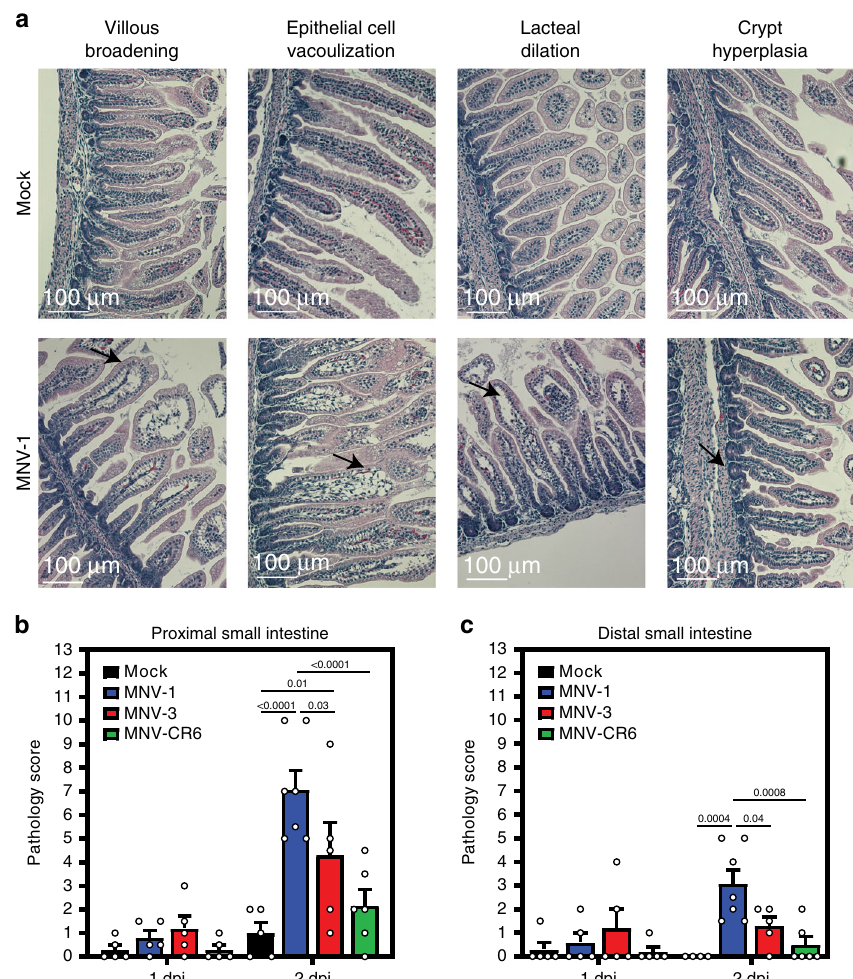
Fig. 3 Neonatal mice infected with MNV-1 show pathological changes. Small intestinal sections collected from neonates infected with 10 8 TCID 50 units of MNV-1 (blue), MNV-3 (red), MNV-CR6 (green), or mock (black) inoculum at 1 dpi ( n = 5 for mock, n = 5 for MNV-1, n = 5 for MNV-3, n = 5 for MNV- CR6) and 2 dpi ( n = 5 for mock, n = 7 for MNV-1, n = 5 for MNV-3, n = 6 for MNV-CR6) were stained with hematoxylin and eosin. Representative images of notable pathology are shown ( a ). Sections were scored blindly by an animal veterinarian for pathological changes in the proximal small intestine ( b ) and distal small intestine ( c ). Scale bars denote 100 µ m. Error bars denote standard errors of mean in all fi gures. P values were determined using two-way ANOVA with corrections for multiple comparisons. Source data are provided as a Source data fi le.